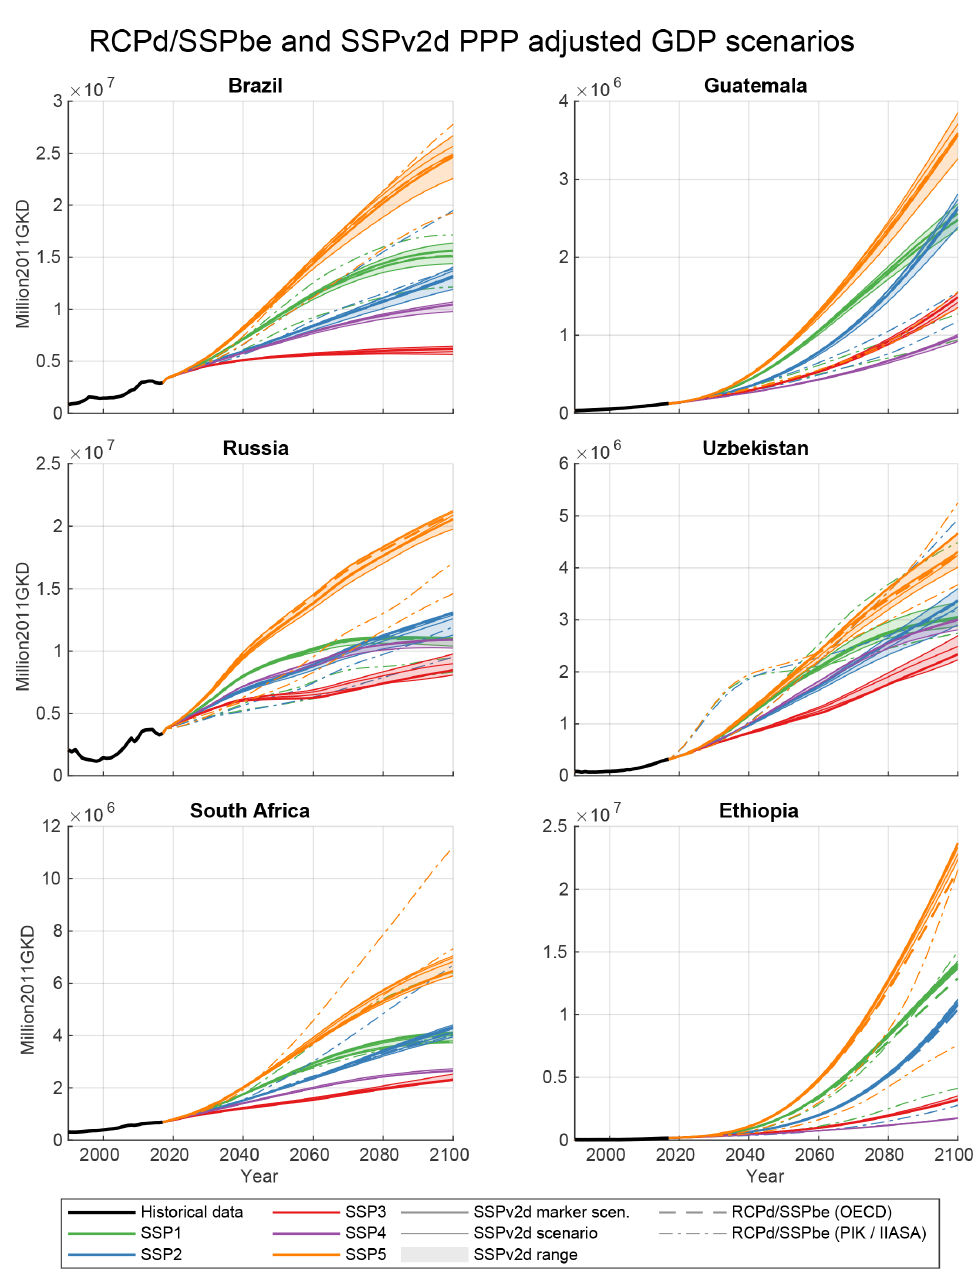
Figure 7. GDP projections for all SSPs (basic elements and downscaled SSPv2). All scenarios harmonized to historical values. Countries from the regions of Latin America, reforming economies, and the Middle East and Africa. The SSP-basic-elements data from PIK and IIASA vary substantially from the OECD data and the OECD-based SSPv2 data for some countries and